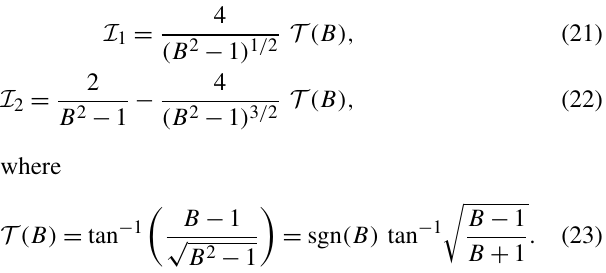
Figure 2. A/A 0 versus x/X eO for homogeneous conditions. (a) ν < 0 for B 0 = [ 10 − 1 , 10 − 2 , 10 − 4 ] (solid lines from left